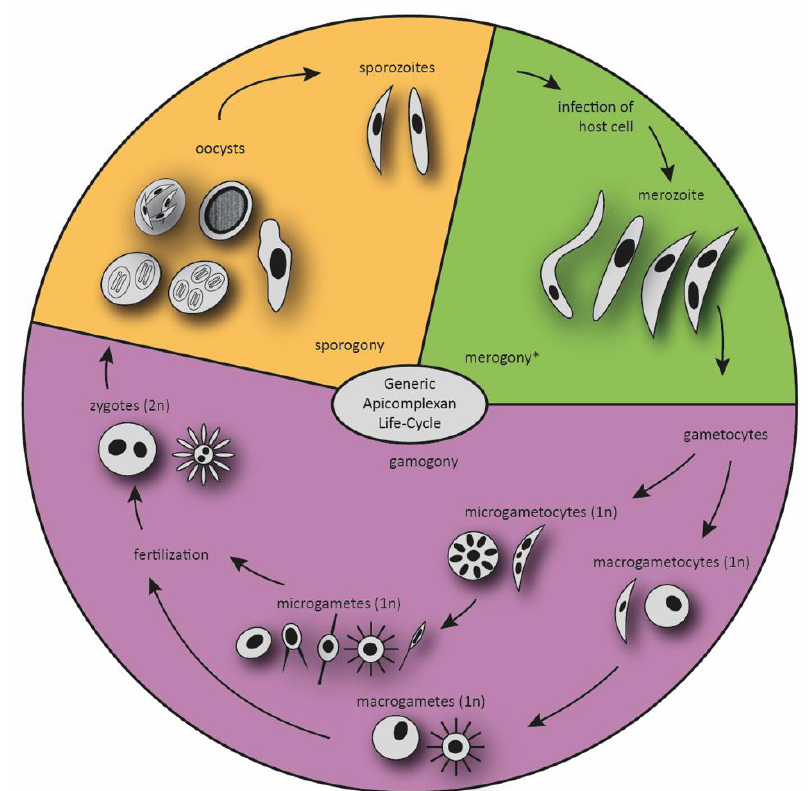
Figure 1. The generic life cycle of Apicomplexa, with a focus on gamogony. The apicomplexan parasites have complex life cycles that are characterized by three distinct processes: sporogony, merogony and gamogony. Transmissible stages are sporozoites, and in heteroxenous life cycles, merozoites or gametocytes. The various stages develop taxon-specifically in different forms and numbers. *In certain Apicomplexans, multiple merozoites will develop from meronts. After several rounds of merogony merozoites can develop into schizonts again, the parasite amount in the host animal can rise quickly. The different forms of all stages represent the variety of Apicomplexa developmental stages. Oocysts can be found in unsporulated and sporulated forms. The amount of nuclei varies regarding the parasite species and the parasite stage.